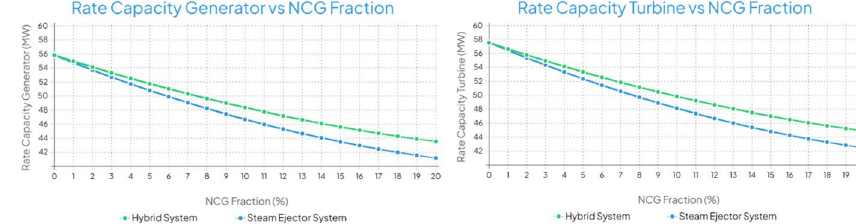
Fig. 17 Rate capacity generator and turbine vs NCG Fraction